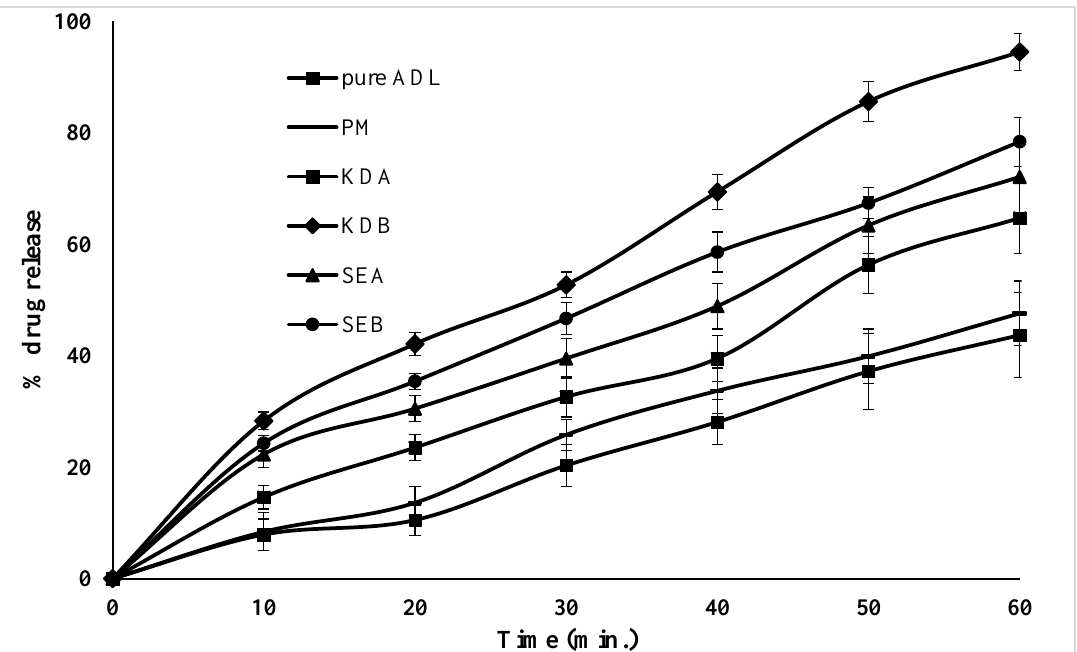
Figure 6. In vitro release profile of pure ADL, the PM and their binary and ternary complexes. Arbidol (ADL); physical mixture (PM); binary kneaded ADL/β-CD (KDA); ternary kneaded ADL/β-CD with 1% poloxamer 188 (KDB); binary solvent evaporated ADL/β-CD (SEA); ternary solvent evaporated ADL/β-CD with 1% poloxamer 188 (SEB).